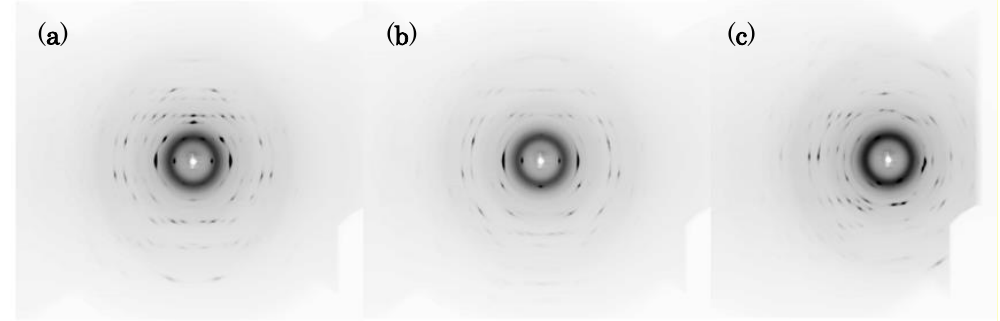
Figure 3. X-ray di ff raction patterns of an α -glycine magnetically oriented microcrystal suspension (MOMS) taken at oscillation angles of φ , defined in Figure 1c: ( a ) 5 ◦ < φ < 15 ◦ at α = 90 ◦ , ( b ) 95 ◦ < φ < 105 ◦ at α = 90 ◦ , ( c ) 35 ◦ < φ < 45 ◦ at α = 120 ◦ .